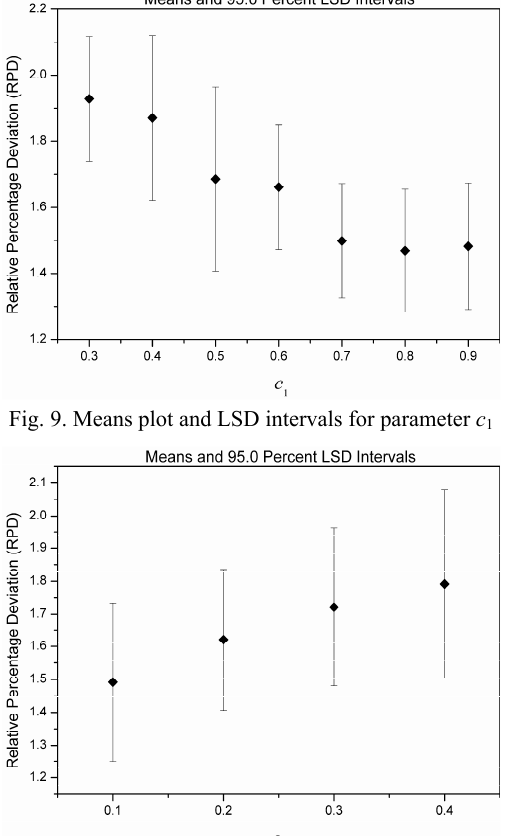
Fig. 11. Means plot and LSD intervals for parameter